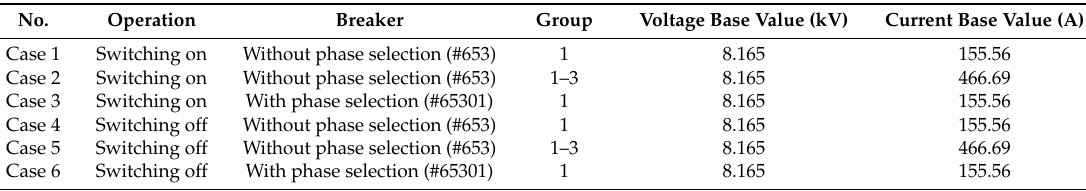
Table 2. Typical cases of switching 10 kV shunt capacitor